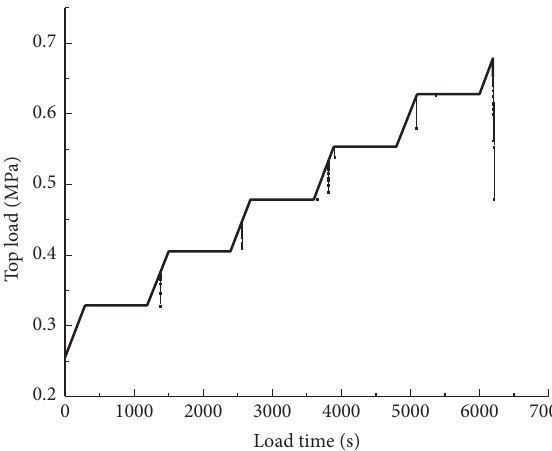
Figure 15: Variation of load of support model with testing